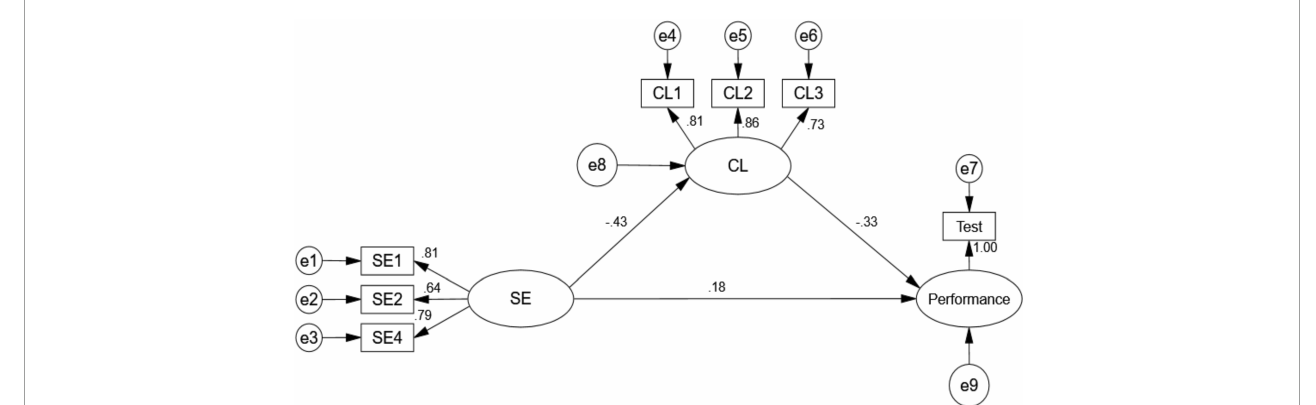
FIGURE1 Structural equation modeling (SEM) of the hypothesized model. SE, self-efficacy; CL, cognitive load.